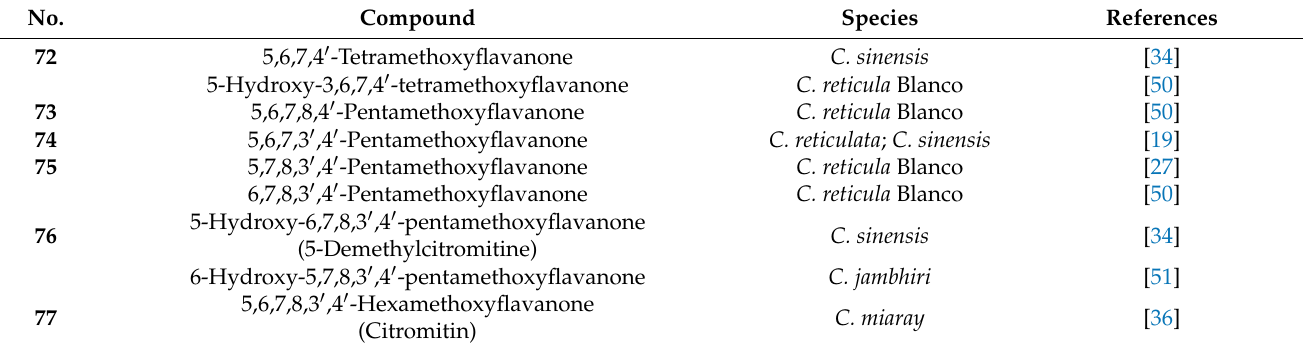
Table 2. Polymethoxyflavanones identified in the genus Citrus .